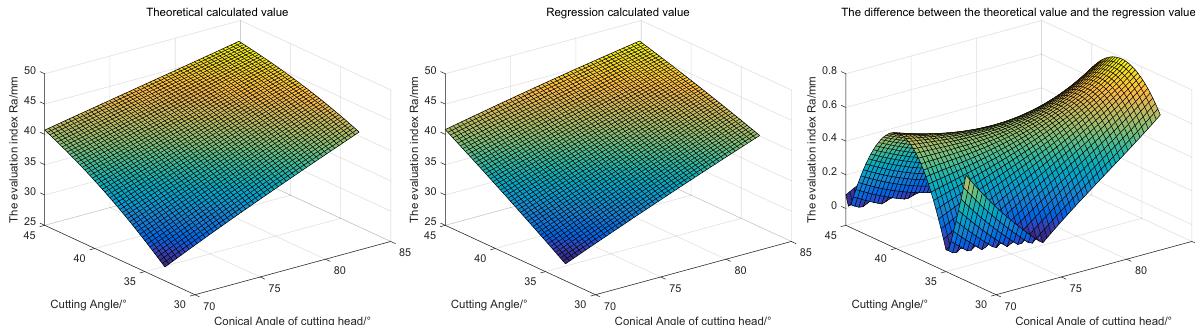
Figure 12. The influence of different cutting Angle and conical Angle of cutting head on evaluation